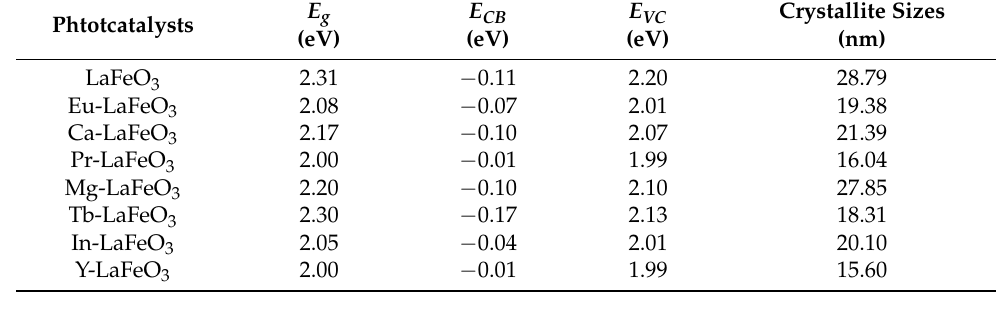
Figure 1. ( a ) The hydrogen evolution and ( b ) DRS curves of different metal doped LaFeO 3 . Table 1. Different photocatalysts and their E g , E CB , E VC , and crystallite sizes.